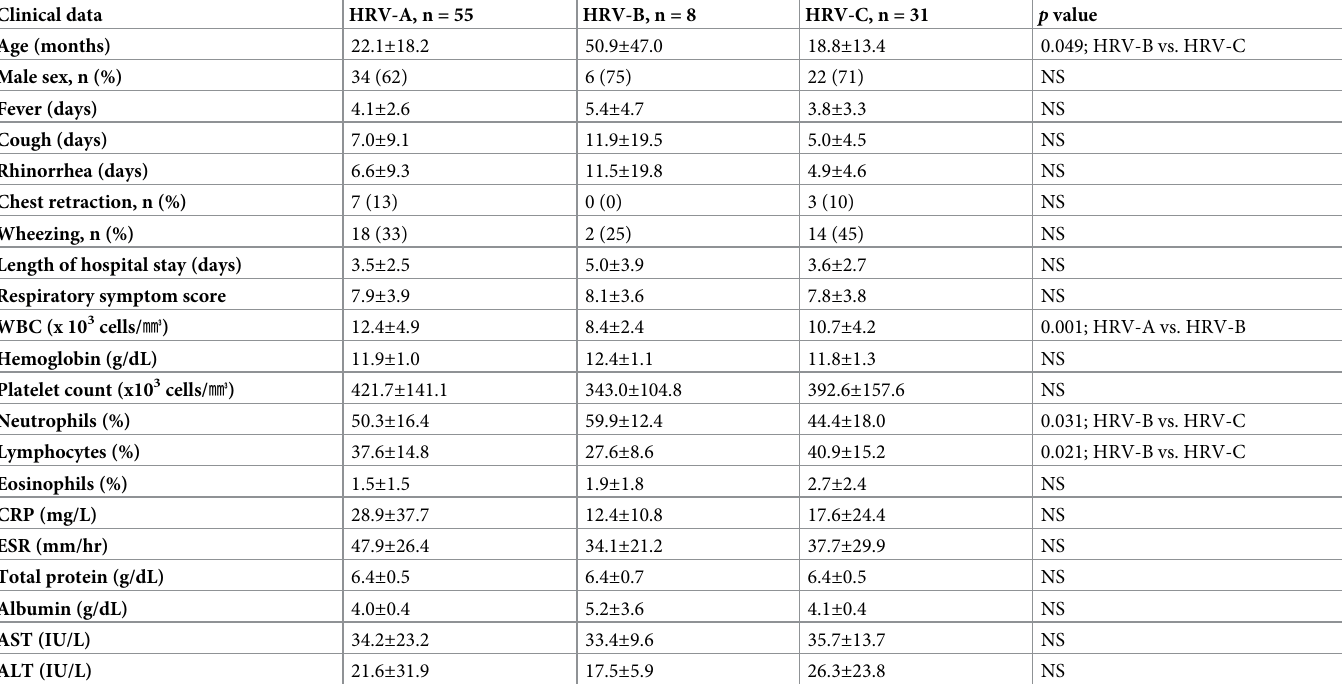
Table 2. Demographic, clinical and laboratory characteristics of patients with HRV-A, -B and -C infections.